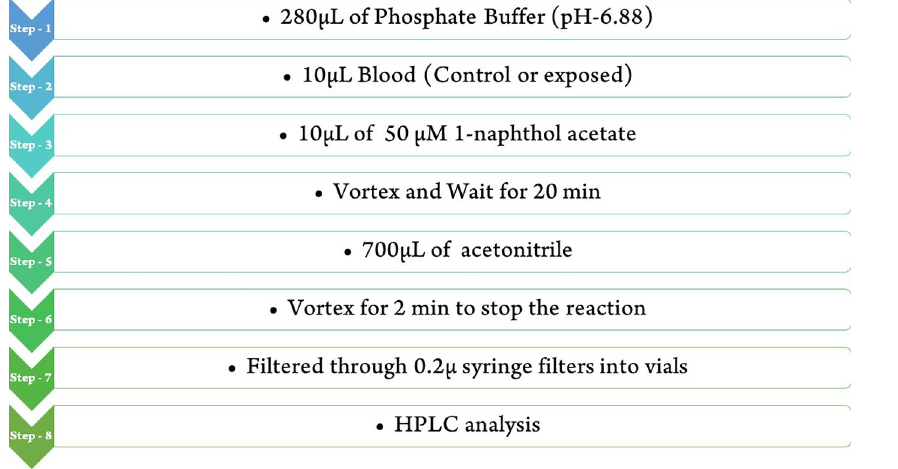
Fig 1. Schematic representation of reaction